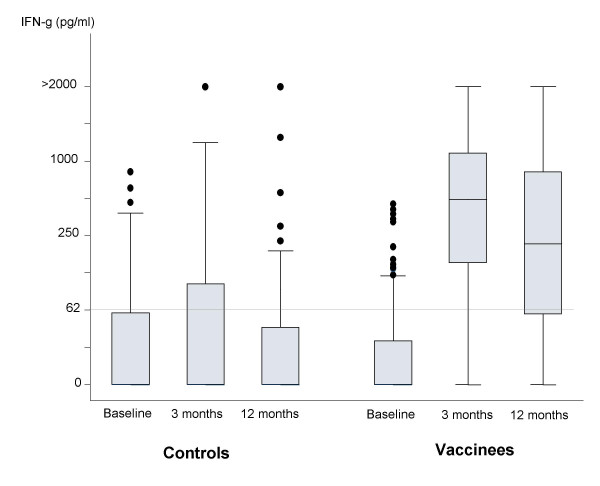
IFN-γ response to M.tb PPD at baseline, and at 3 and 12 months following BCG vaccination, among teenage unvaccinated controls and vaccinees. Control subjects n = 62, vaccinated subjects n = 86. Each box shows the median and 25th and 75th centiles. The "whiskers" show the minimum and maximum values other than outliers which are represented as dots above the "whiskers". Grey line represents threshold of positive IFN-γ response (> 62 pg/ml; twice the limit of detection of the assay (31 pg/ml) [13]).